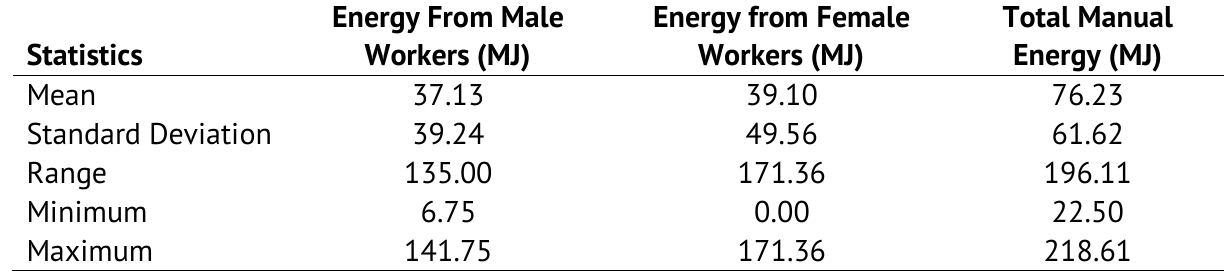
Descriptive statistics on manual energy (n=10)